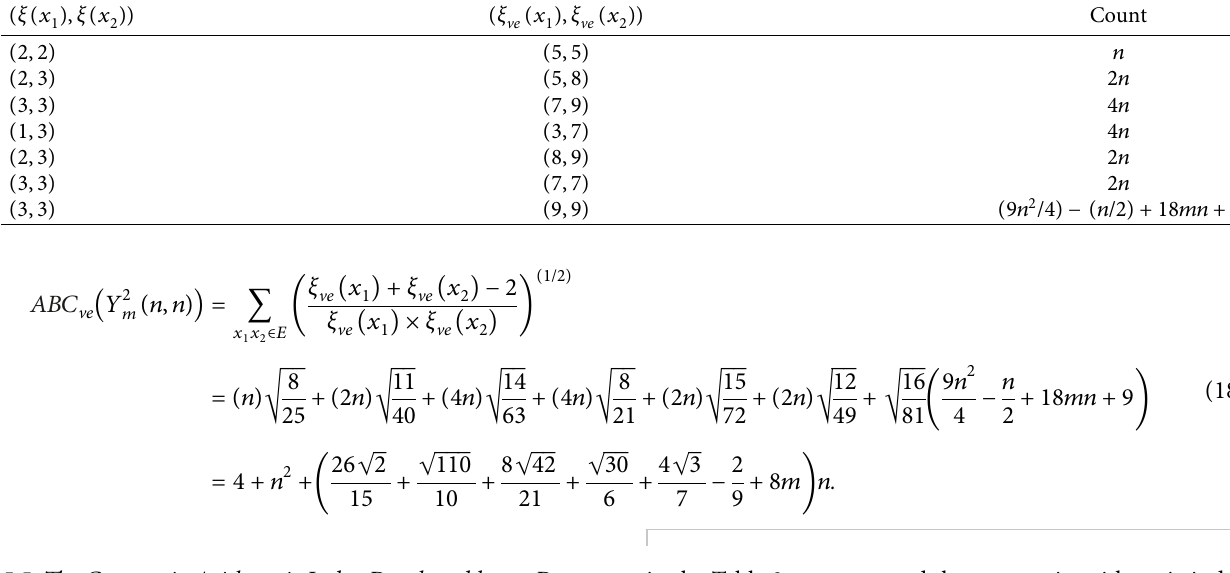
Table 3: The ve -degrees of each edge of Y 2